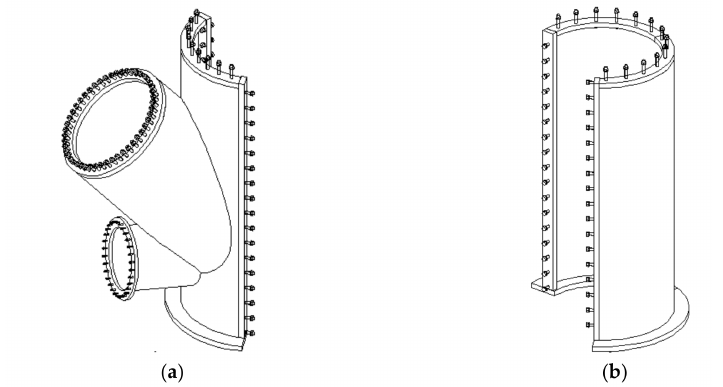
Figure 7. Details of a segmental corner junction piece ( a ) inner part; ( b ) outer part.